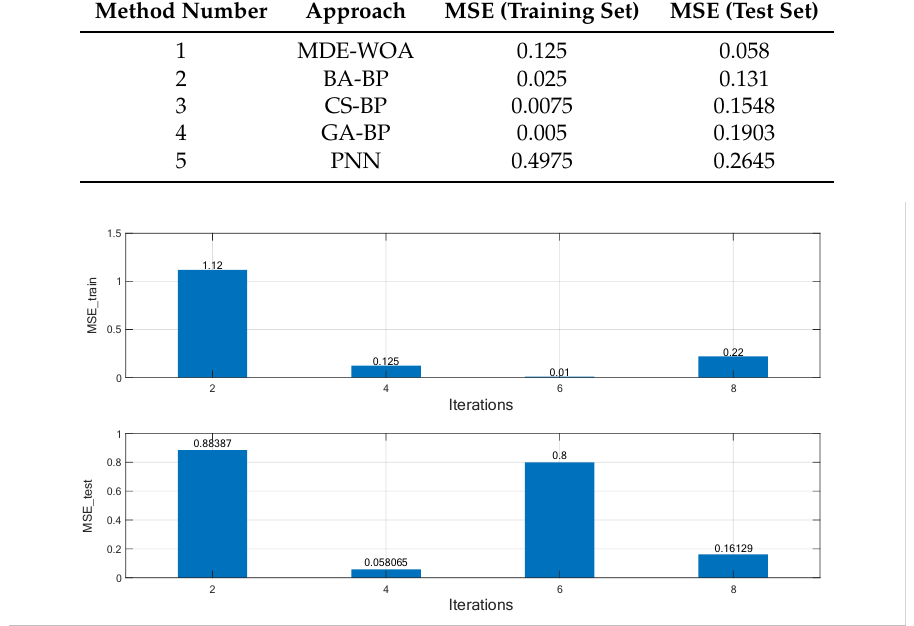
Figure 5. MSE between training sample and test sample.